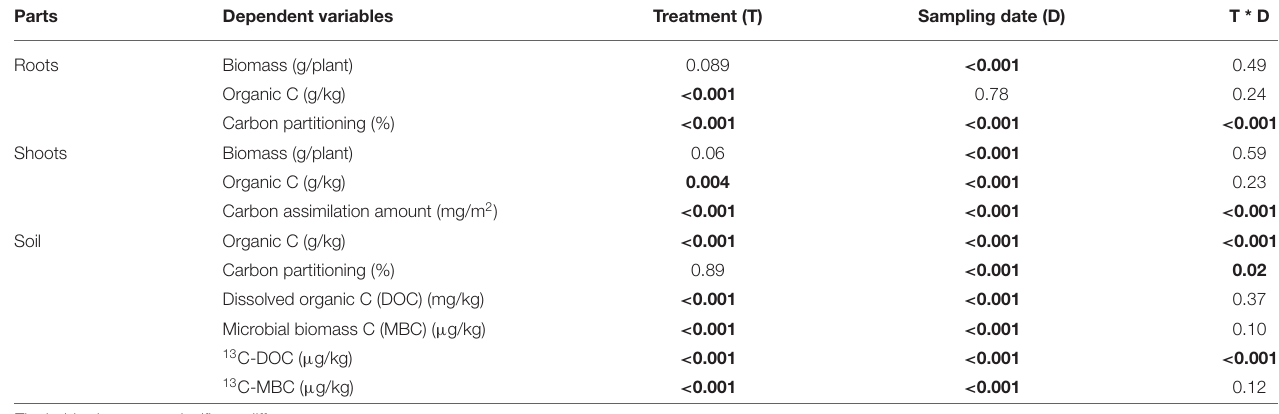
TABLE 2 | Results of analysis of variance ( P -values) for various parameters in the maize-soil system as influenced by different treatments at three sampling dates. Parts